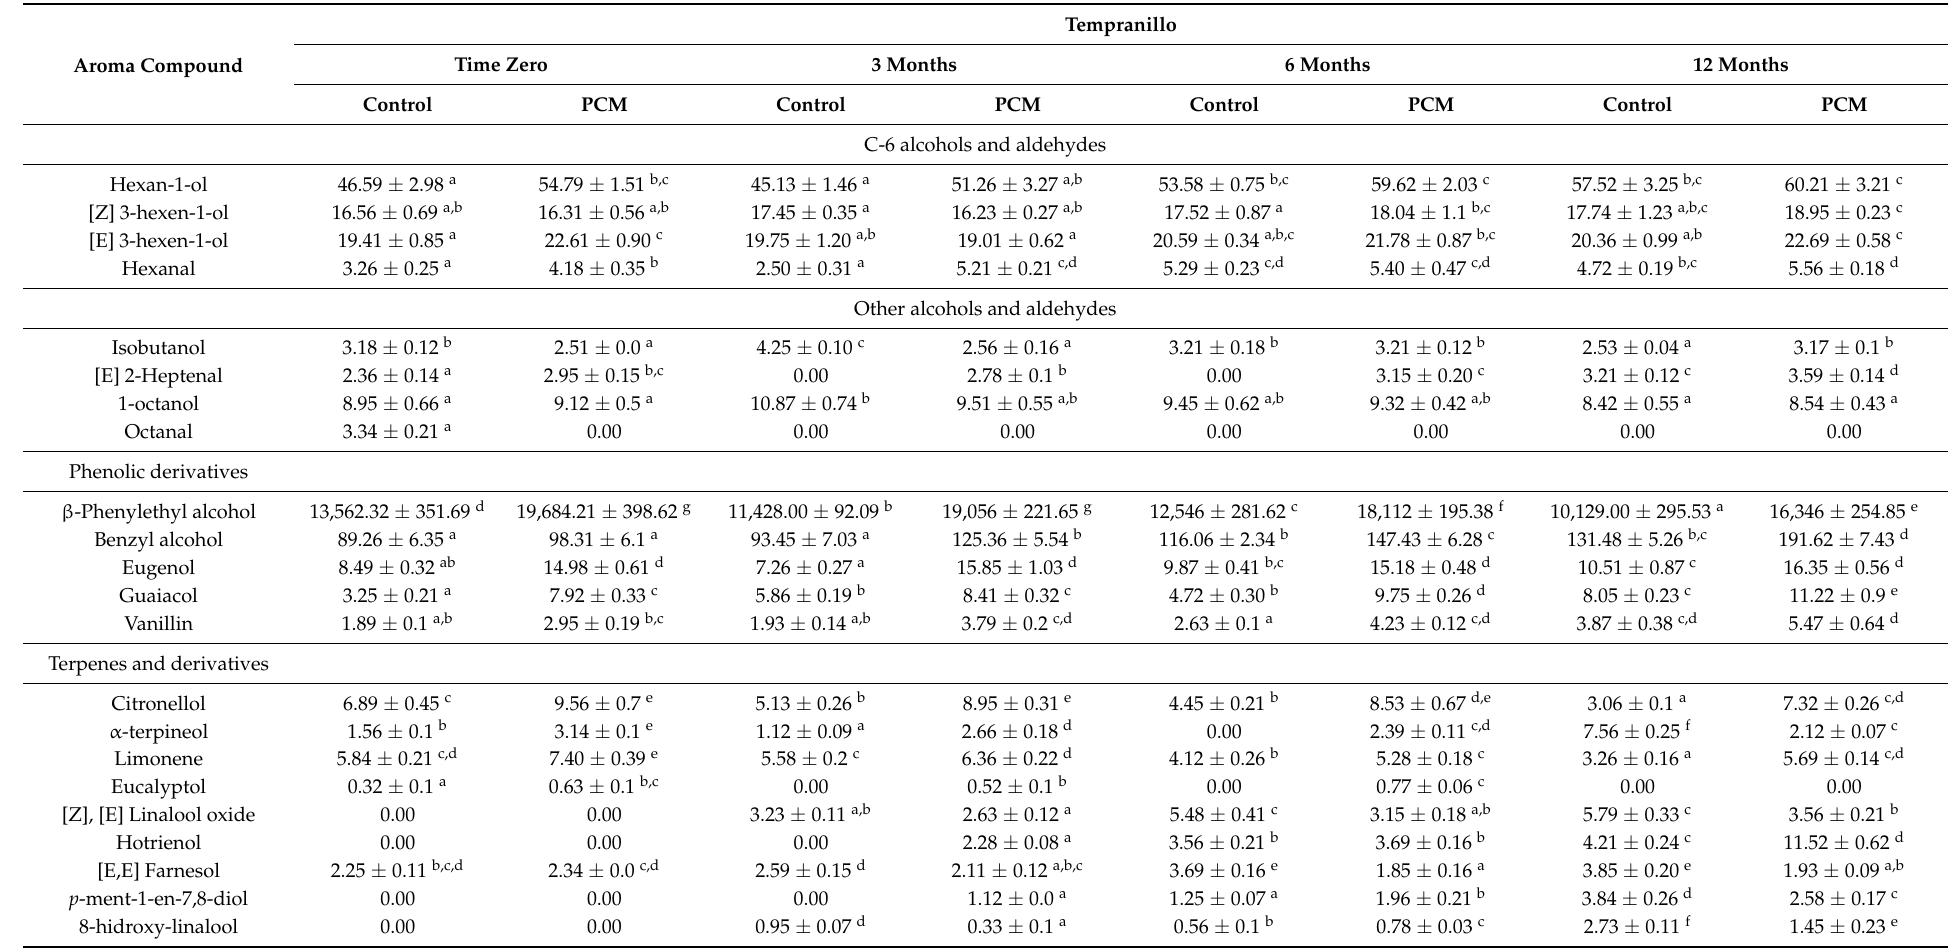
Table 4. Aromatic composition of Tempranillo wines during bottling. Values are expressed as µ